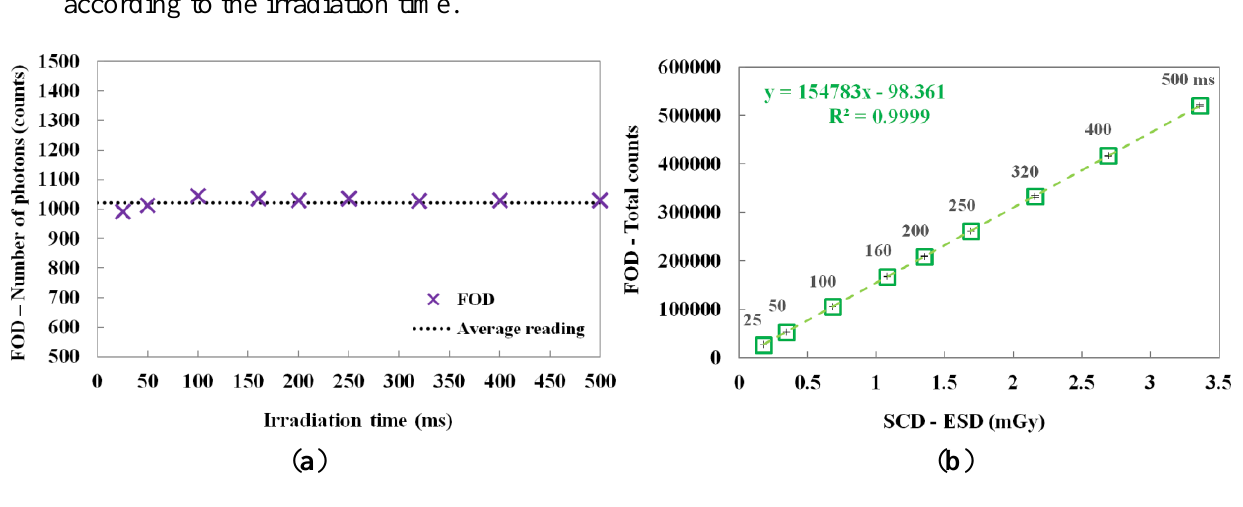
Figure 6. ( a ) Number of scintillation photons measured by the FOD during X-ray irradiation. ( b ) Relationship between the total counts of the FOD and the ESDs of the SCD according to the irradiation